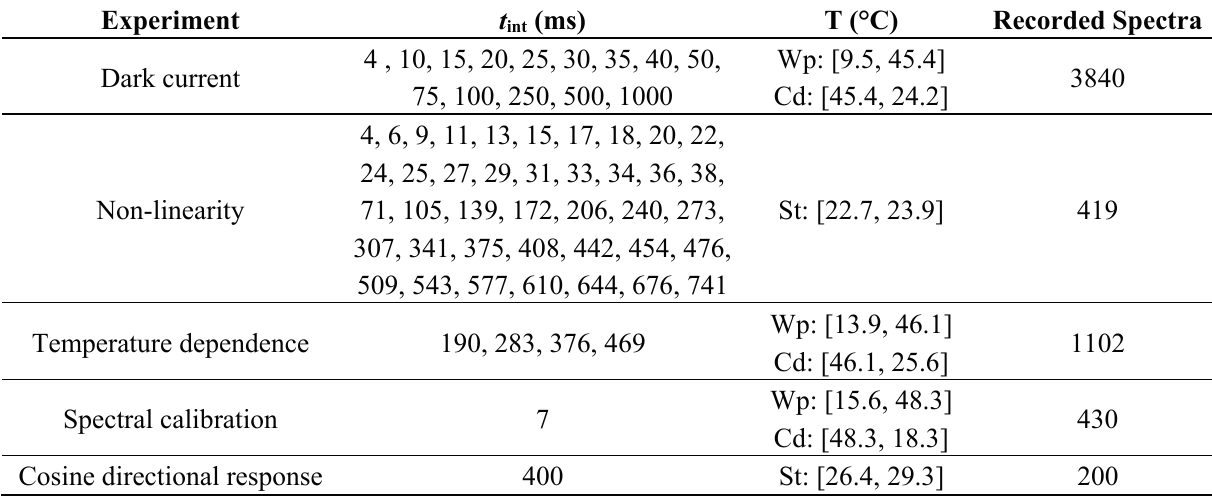
Table 1. Summary of the calibration experiments carried out with the Unispec DC spectroradiometer. In the third column: Wp = Warm-up model. Cd = Cool-down model. St = Stable